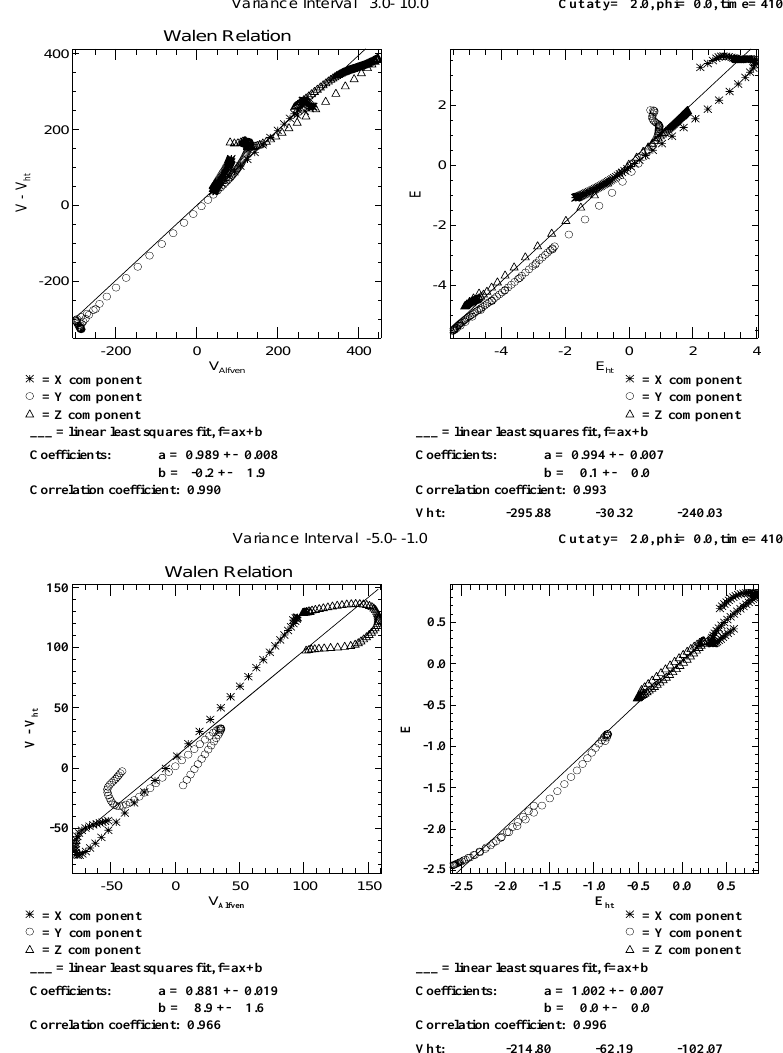
Fig. 12. Wal´en relation (left) and deHoffmann-Teller frame (right) “measured” by virtual spacecraft during cut at y =2 between x =[3,10] (top), and between x =[ − 5, − 1]